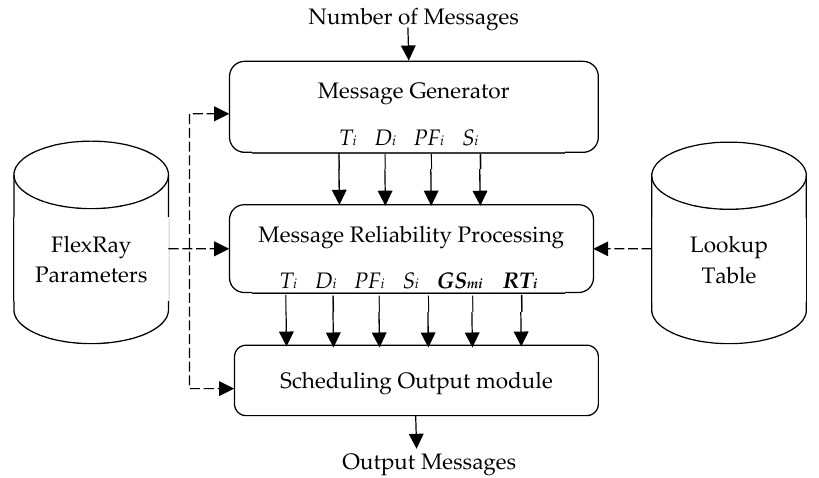
Figure 2. The proposed fast reliability scheduling algorithm (FRSA) architecture.